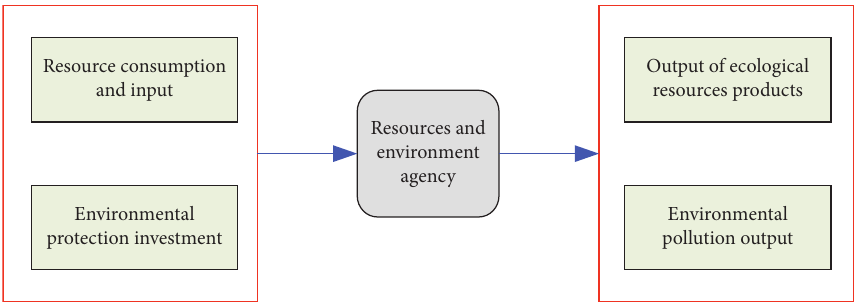
Figure 1: Schematic diagram of the relationship between input and output of resources and environment